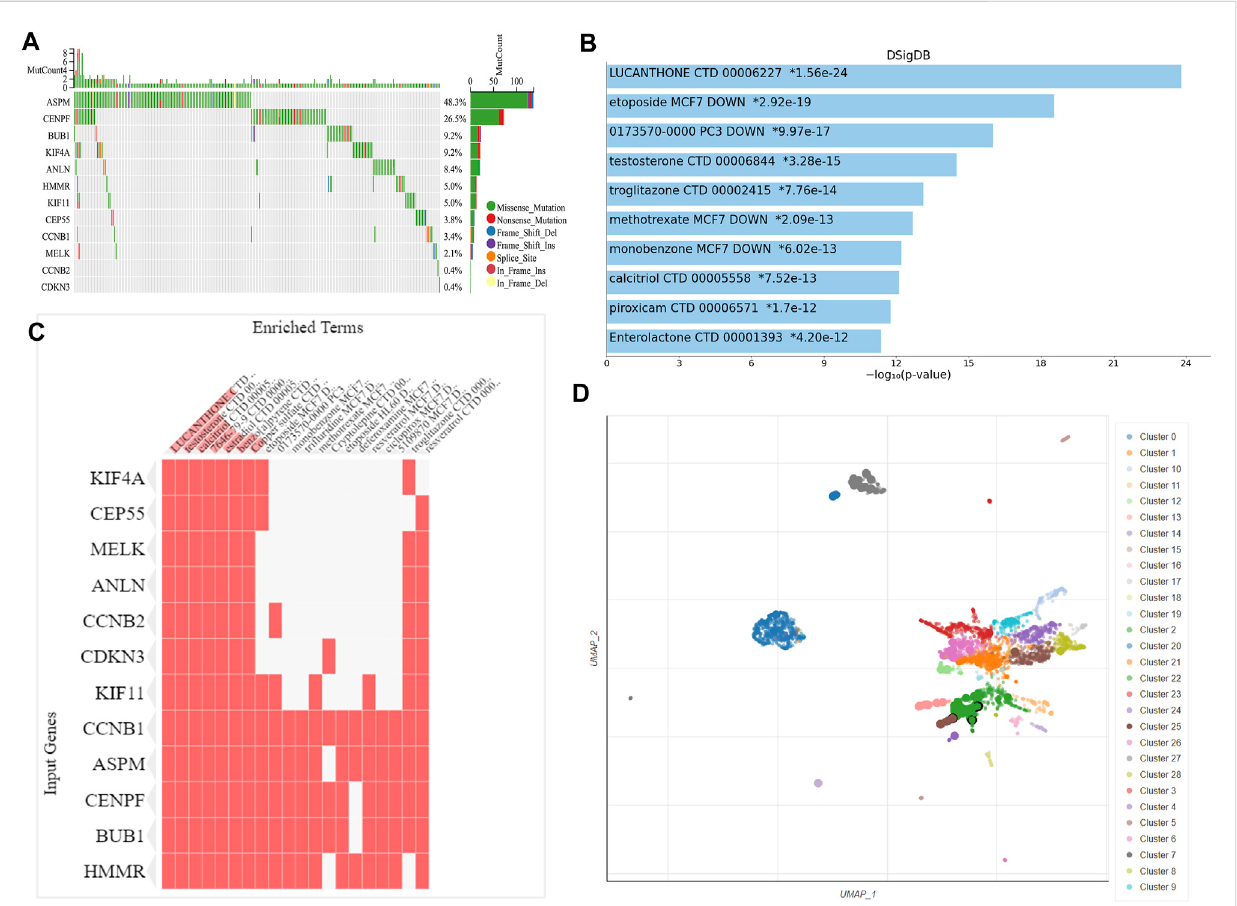
FIGURE 6 Genetic alteration analysis and enrichment analysis of the key gene-related drugs. (A) Mutation pro fi le of the 12 key genes in NSCLC. Enrichment analysis of the key gene-related drugs by Enrichr platform and shown by bar chart (B) , heat map (C) and scatterplot (D) . NSCLC, non-small cell lung